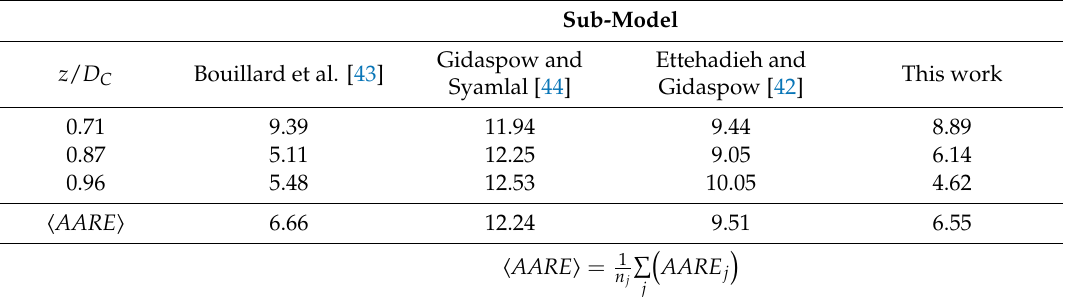
(cid:68) (cid:69) V β / V ms = 1.1. 0